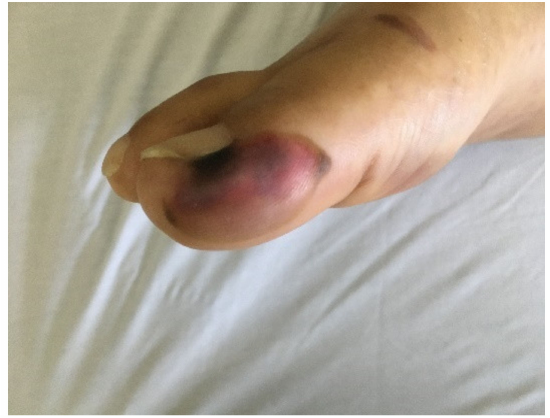
Figure 3. Skin lesions with a tendency to blister with subsequent necrosis on the right first toe of a patient confirmed for COVID-19.